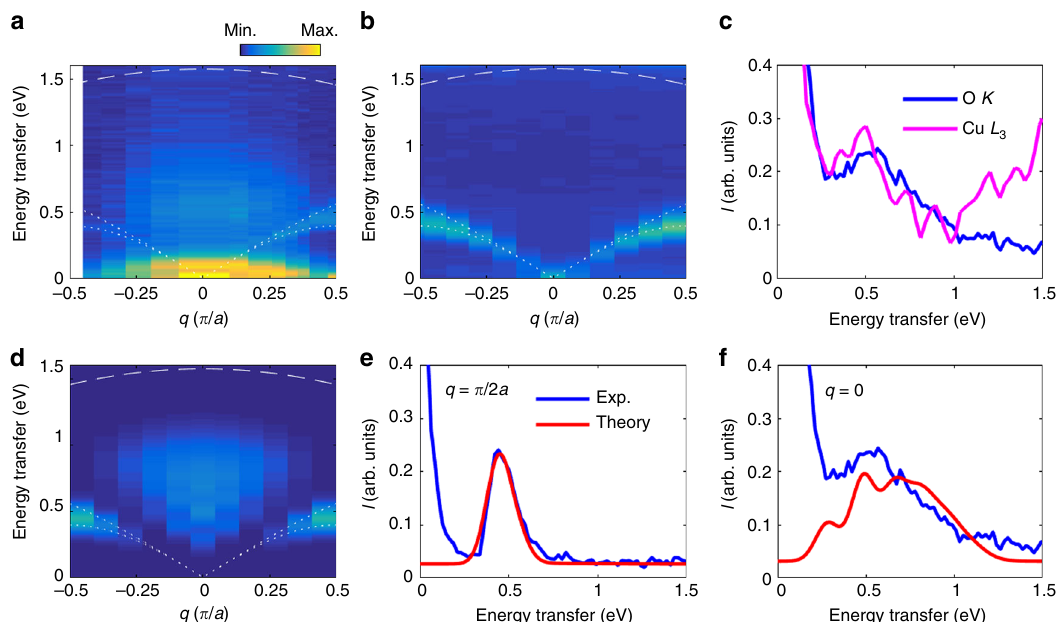
Fig. 2 Comparison between the experimental and calculated RIXS spectra at the oxygen K -edge. a , b Experimental RIXS spectra as a function of momentum transfer and energy transfer measured at the oxygen K -edge with an incident photon energy of ℏ ω in = 528.6 eV (resonance B) ( a ) and at the copper L 3 - edge from ref. 4 ( b ). c compares the O K -edge (blue) and Cu L 3 -edge (magenta line) RIXS line cuts at q = 0. In the case of Cu L 3 data, there is a tailing contribution from higher energy dd excitations, which extends down to low energy transfer (see Supplementary Note 3). d displays the calculated oxygen K -edge spectra for ℏ ω = 500 meV. (This value optimizes the intensity of the four-spinon features, see Supplementary Note 5.) The excitation around in 90 meV in the oxygen K -edge data is a phonon excitation not included in our model calculations. The modeled RIXS intensity was obtained from exactly diagonalizing a 22-site t − J chain with periodic boundary conditions and the elastic line has been removed from the data for clarity. e , and f show line cuts of the RIXS spectra at q = π /2 a and q = 0, respectively. The experimental (theoretical) data are represented by the blue (red) solid lines. The intensity of the RIXS data are reported in arbitrary units (arb. units). The dotted and dashed white lines in a , b , and d indicate the boundaries of the two- and four-spinon continua, respectively (for more details on these boundaries see Supplementary Note